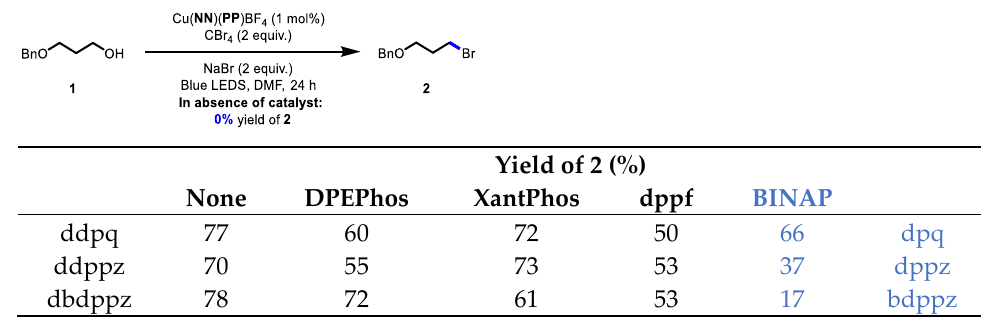
Figure 3. Comparison of the BINAP -containing copper complexes bearing π -extended ligands in a photochemical Appel-type process.